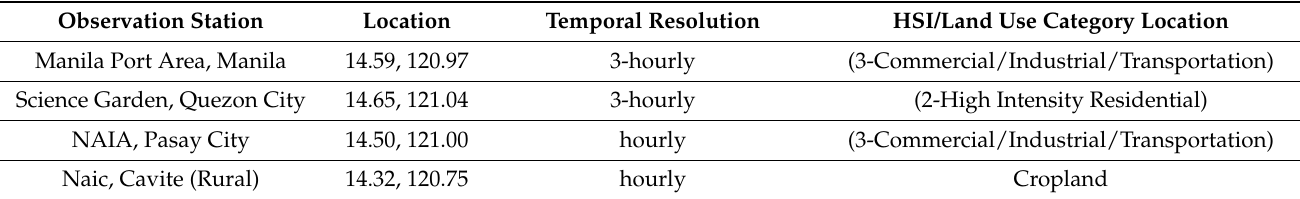
Table 1. Weather stations site information used in this study.